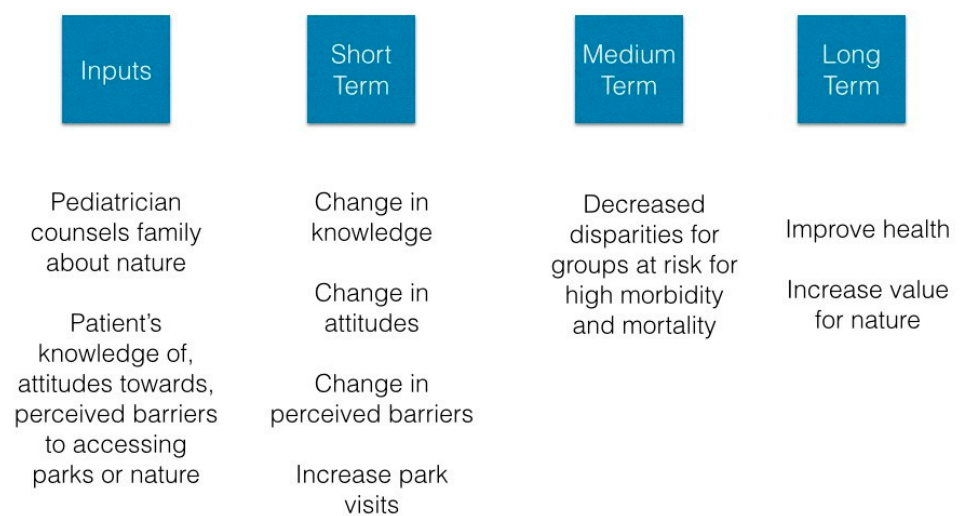
Figure 1. Stay Healthy in Nature Everyday logic model for an individual or family based intervention to increase park visits.